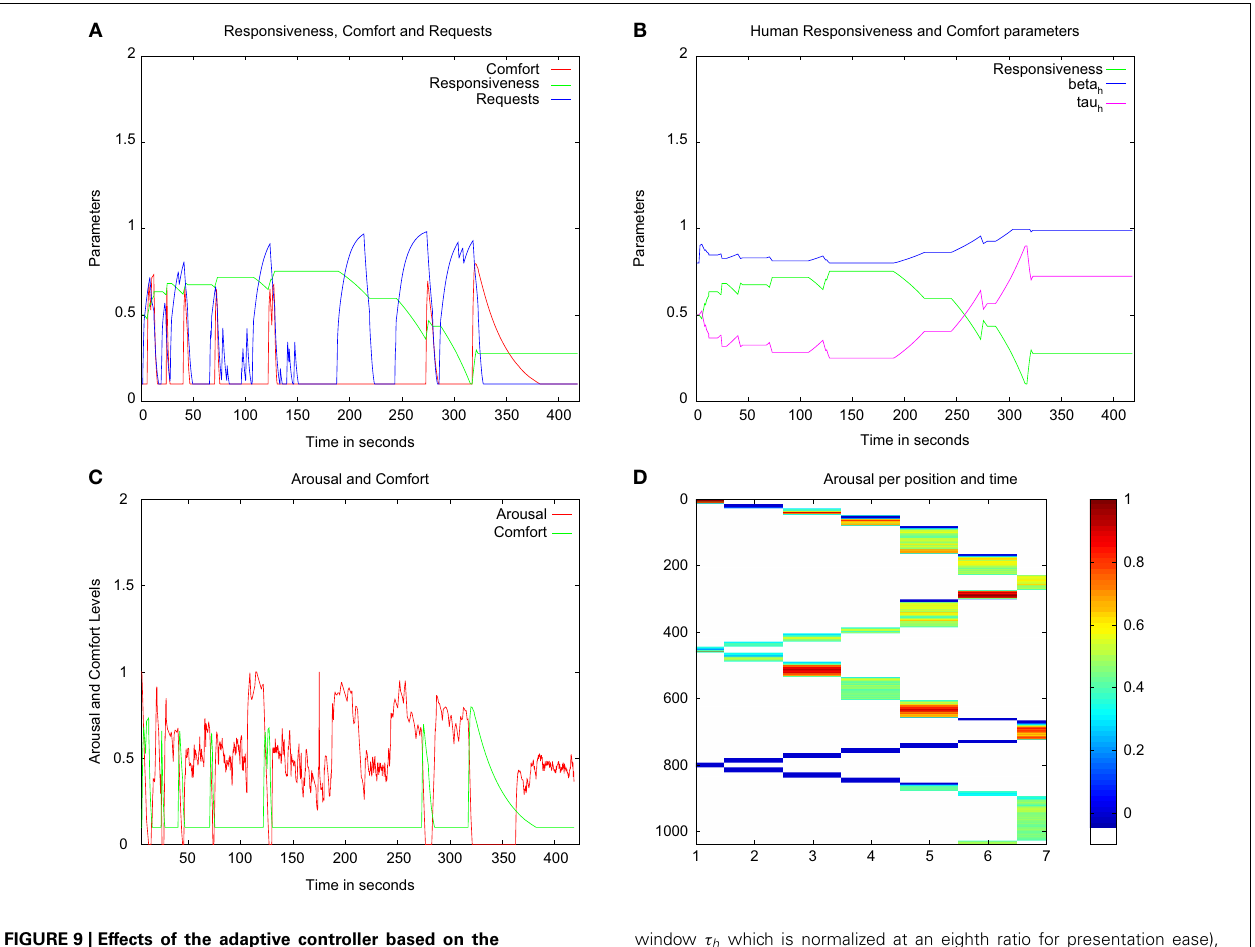
window τ h which is normalized at an eighth ratio for presentation ease), and the evaluated responsiveness of the human. (C) Variations of the comfort (in green) and the arousal level of the robot (in red). (D) Temperature plot of the Arousal level of the robot as a function of time and the position of the